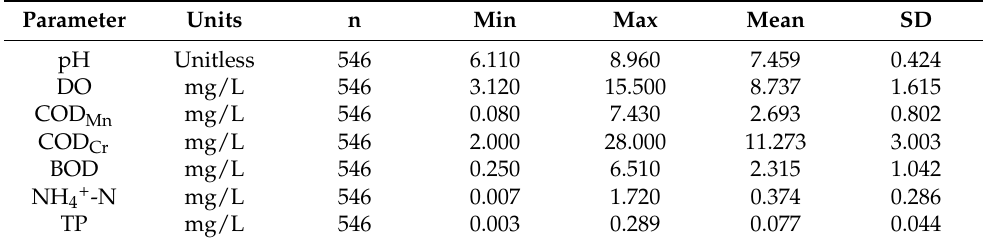
Table 2. Summary of the water quality parameters of research area.